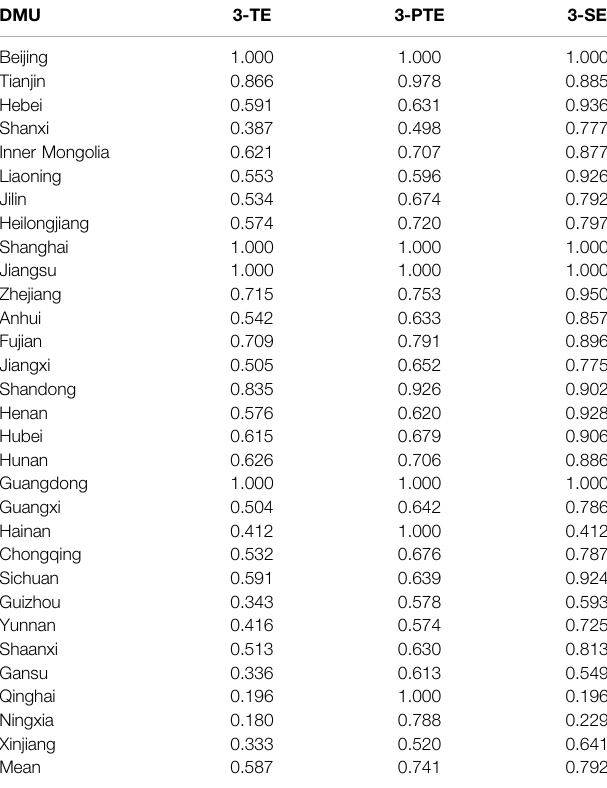
TABLE 3 | Regression results of the third stage. DMU 3-TE 3-PTE 3-SE Beijing